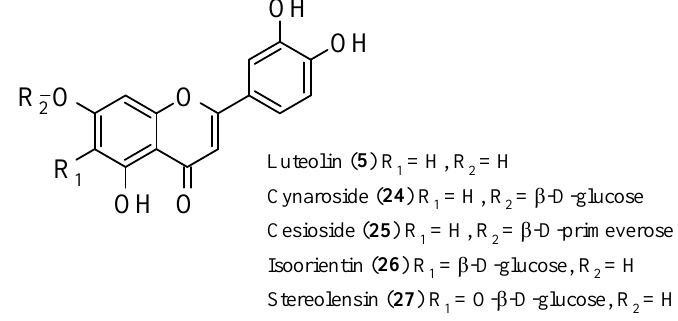
Figure 5. Flavonoids studied for their anti-inflammatory effect [30].